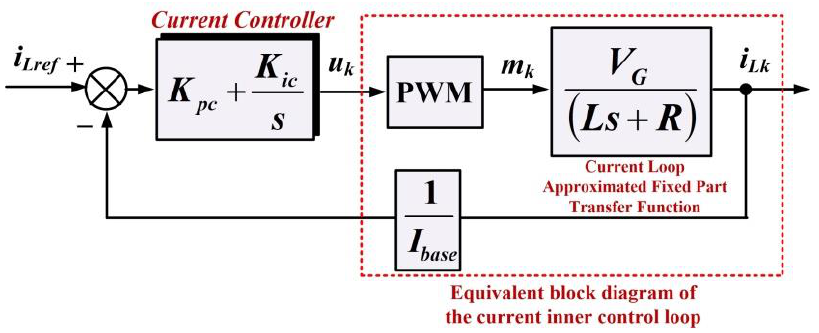
Figure 4. Equivalent block diagram modeled using the transfer function of the inner loop for current regulation.